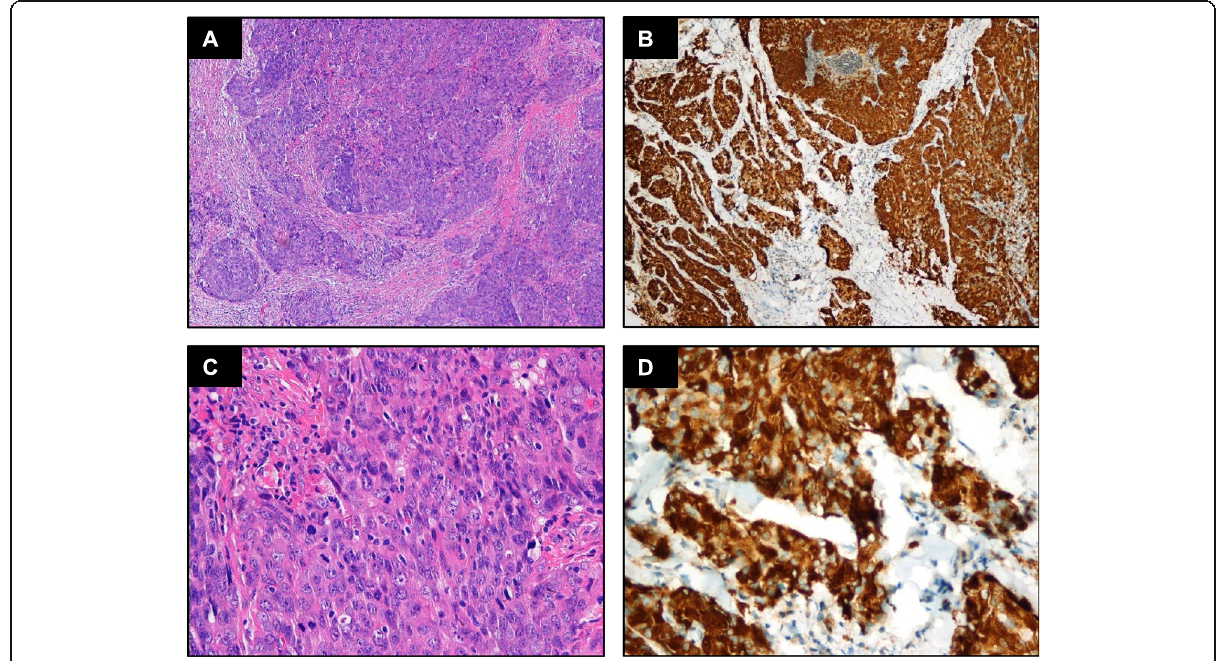
Fig. 3 ( A ) Histomorphology of a high-grade transformed ACC. ( B ) Intensive cytoplasmic LMO2 staining is seen in neoplastic cells. ( C - D ) Higher